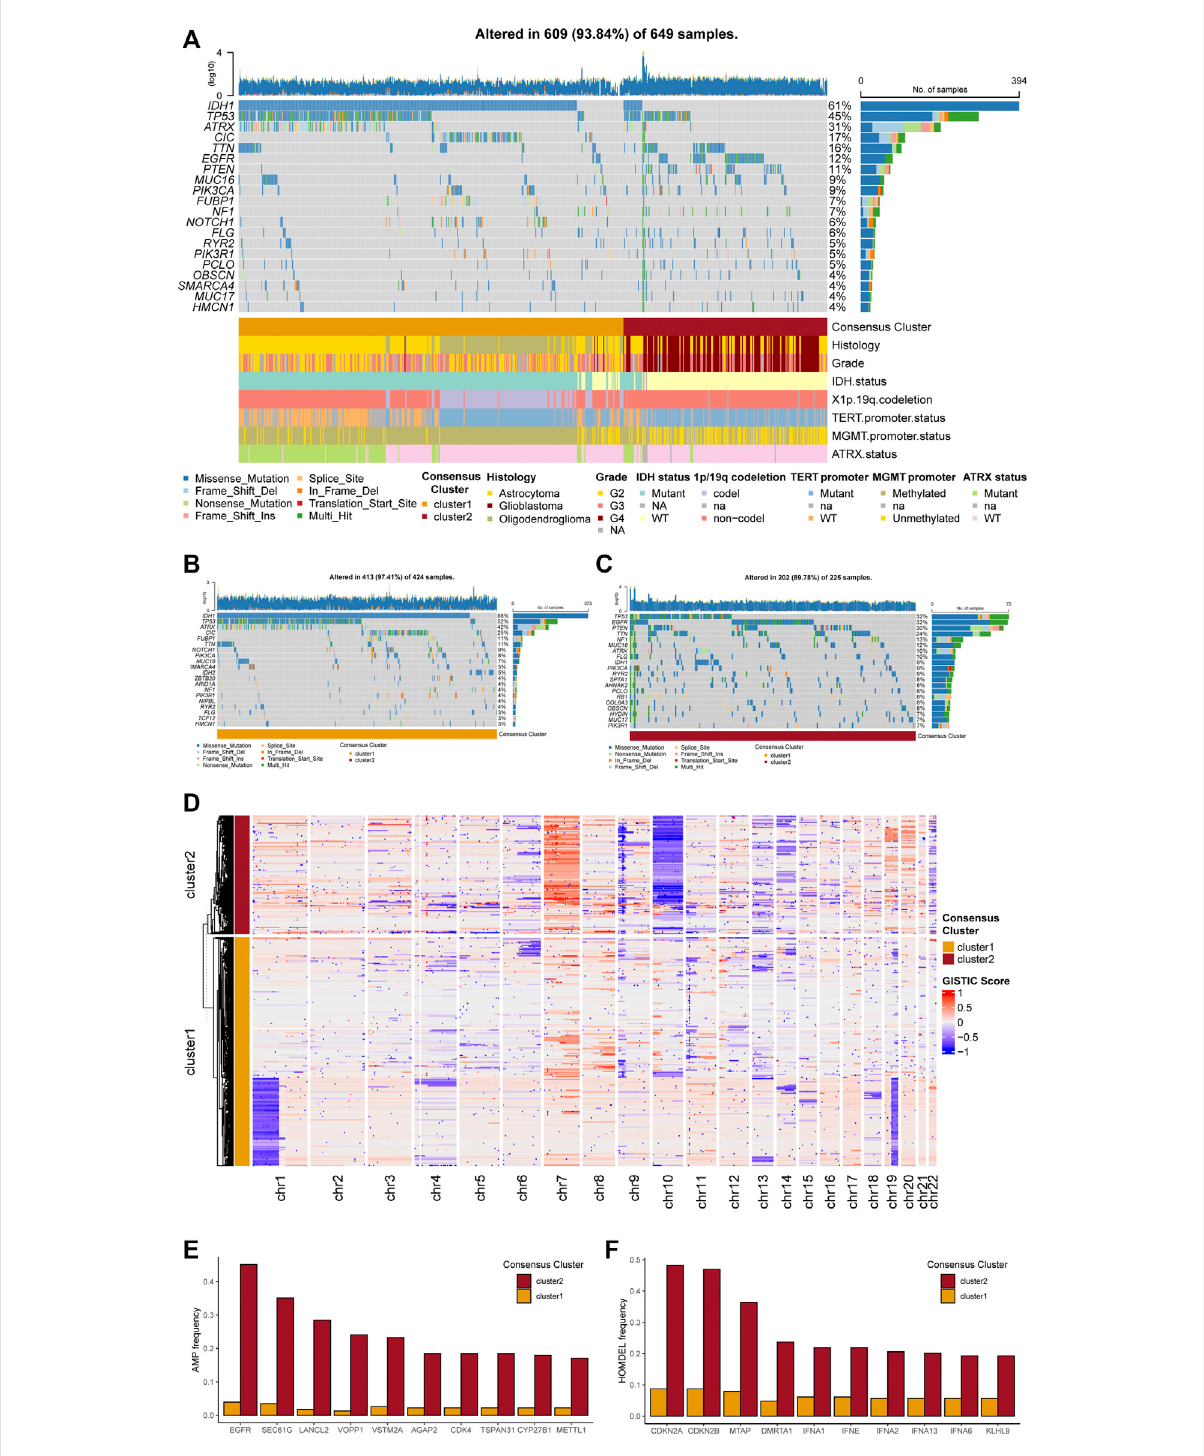
FIGURE 3 Genetic mutations and copy number variations of the two clusters. (A) Gene alterations of top 20 mutated genes. (B) Top 20 mutated genes in cluster 1. (C) Top 20 mutated genes in cluster 2. (D) Heatmap of copy number variations of the two clusters. (E) Top 10 ampli fi cation genes in two clusters. (F) Top 10 homozygously deleted genes in two